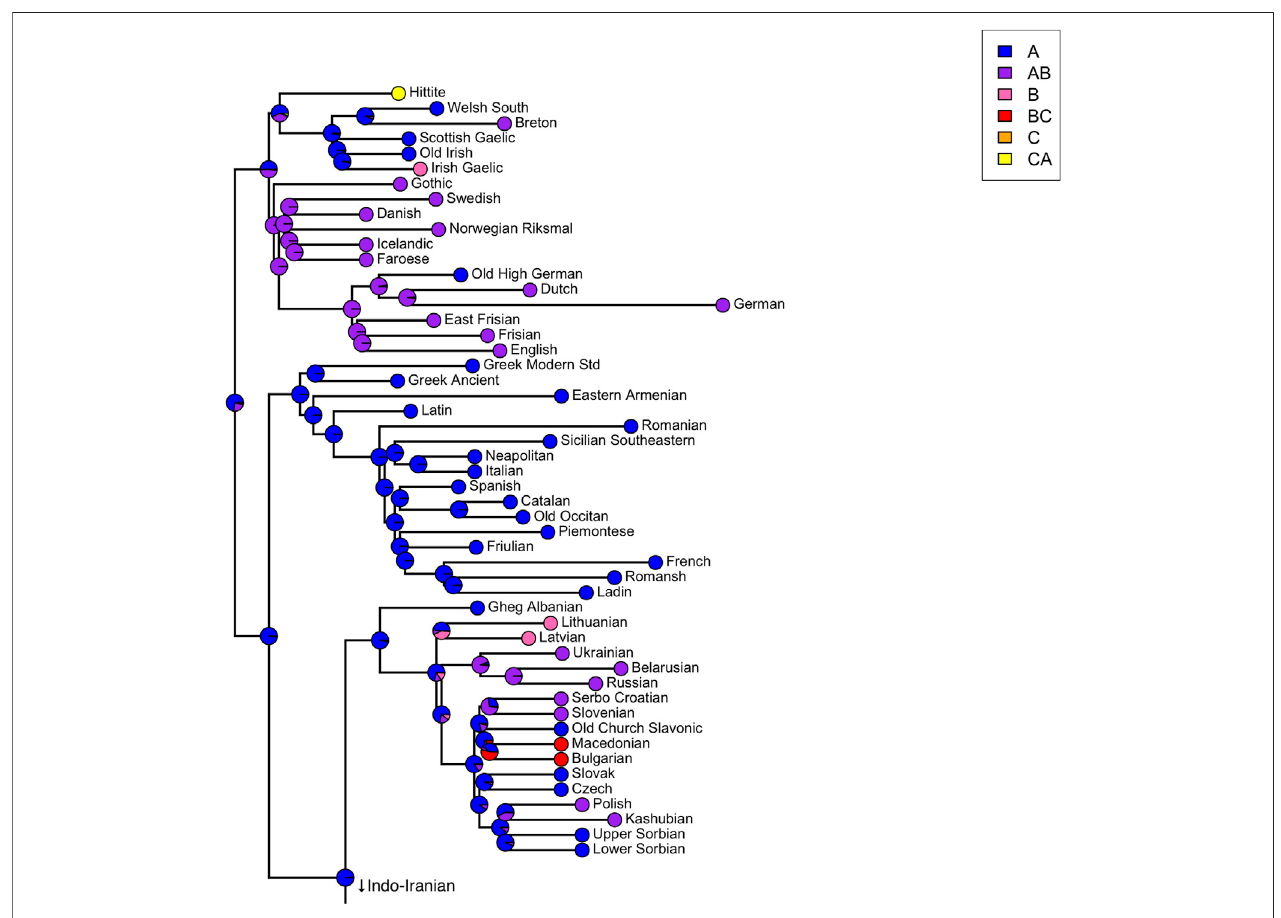
FIGURE 4 | An overview of negative existential construction types in non-Indo-Iranian languages, overlaid on a modi fi ed Indo-European Glottolog tree (Hammarström et al., 2014; Dediu 2018).